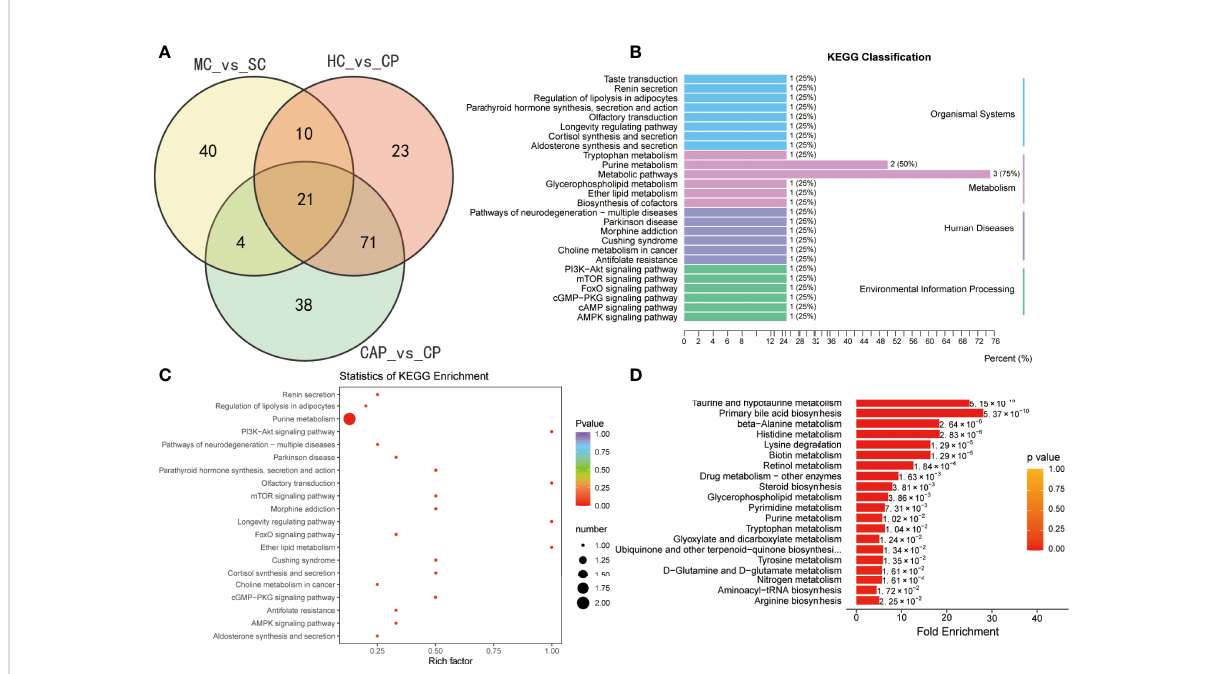
FIGURE 7 Identi fi cation of metabolites speci fi c to severe COVID-19 patients. (A) Venn diagram showing differentially expressed metabolites between three groups: healthy controls (HC) vs. COVID-19 patients (CP), community-acquired pneumonia (CAP) vs. CP, and mild COVID-19 (MC) patients vs. severe COVID-19 (SC). (B) KEGG classi fi cation of common differentially expressed metabolites. KEGG enrichment pathway analysis (C) and Metabolite Set Enrichment Analysis (MSEA) (D) of 21 common differentially expressed